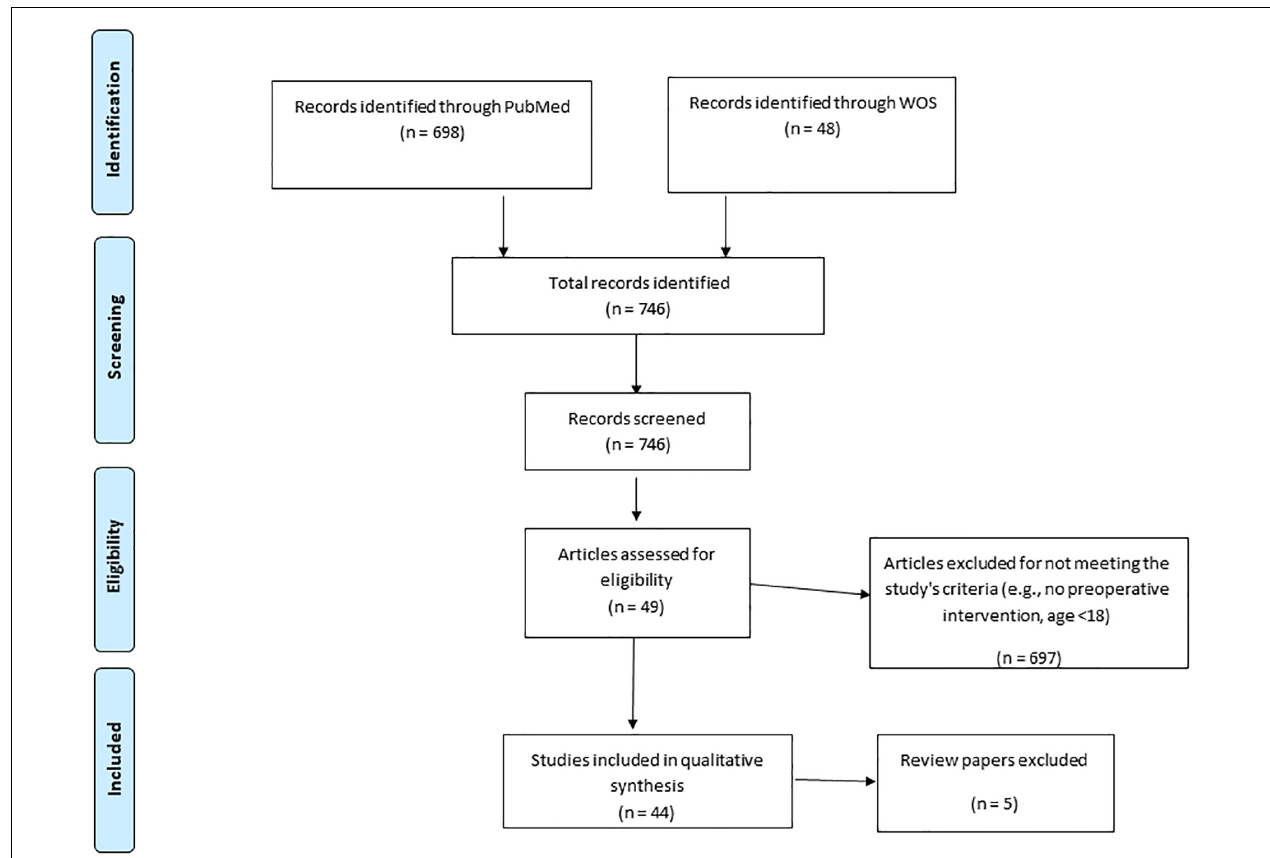
FIGURE 1 | PRISMA-ScR flow